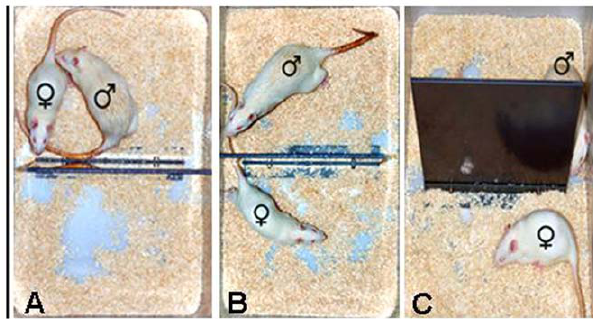
Figure 1. Paced mating (PM) arena. PM was performed in an open- topped PM arena (34 6 31 6 53 cm) divided by a vertical barrier with an interspaces of 3.5 cm between the barrier and the cage’s walls. The PM arena allows size-dependent withdrawal of the female to the other side of the cage and control of mating frequency and performance of microdialysis during ongoing PM. (A) anogenital investigation of the female by the male, (B) escape of the female to the other side of the barrier, (C) separation of male and female rats.